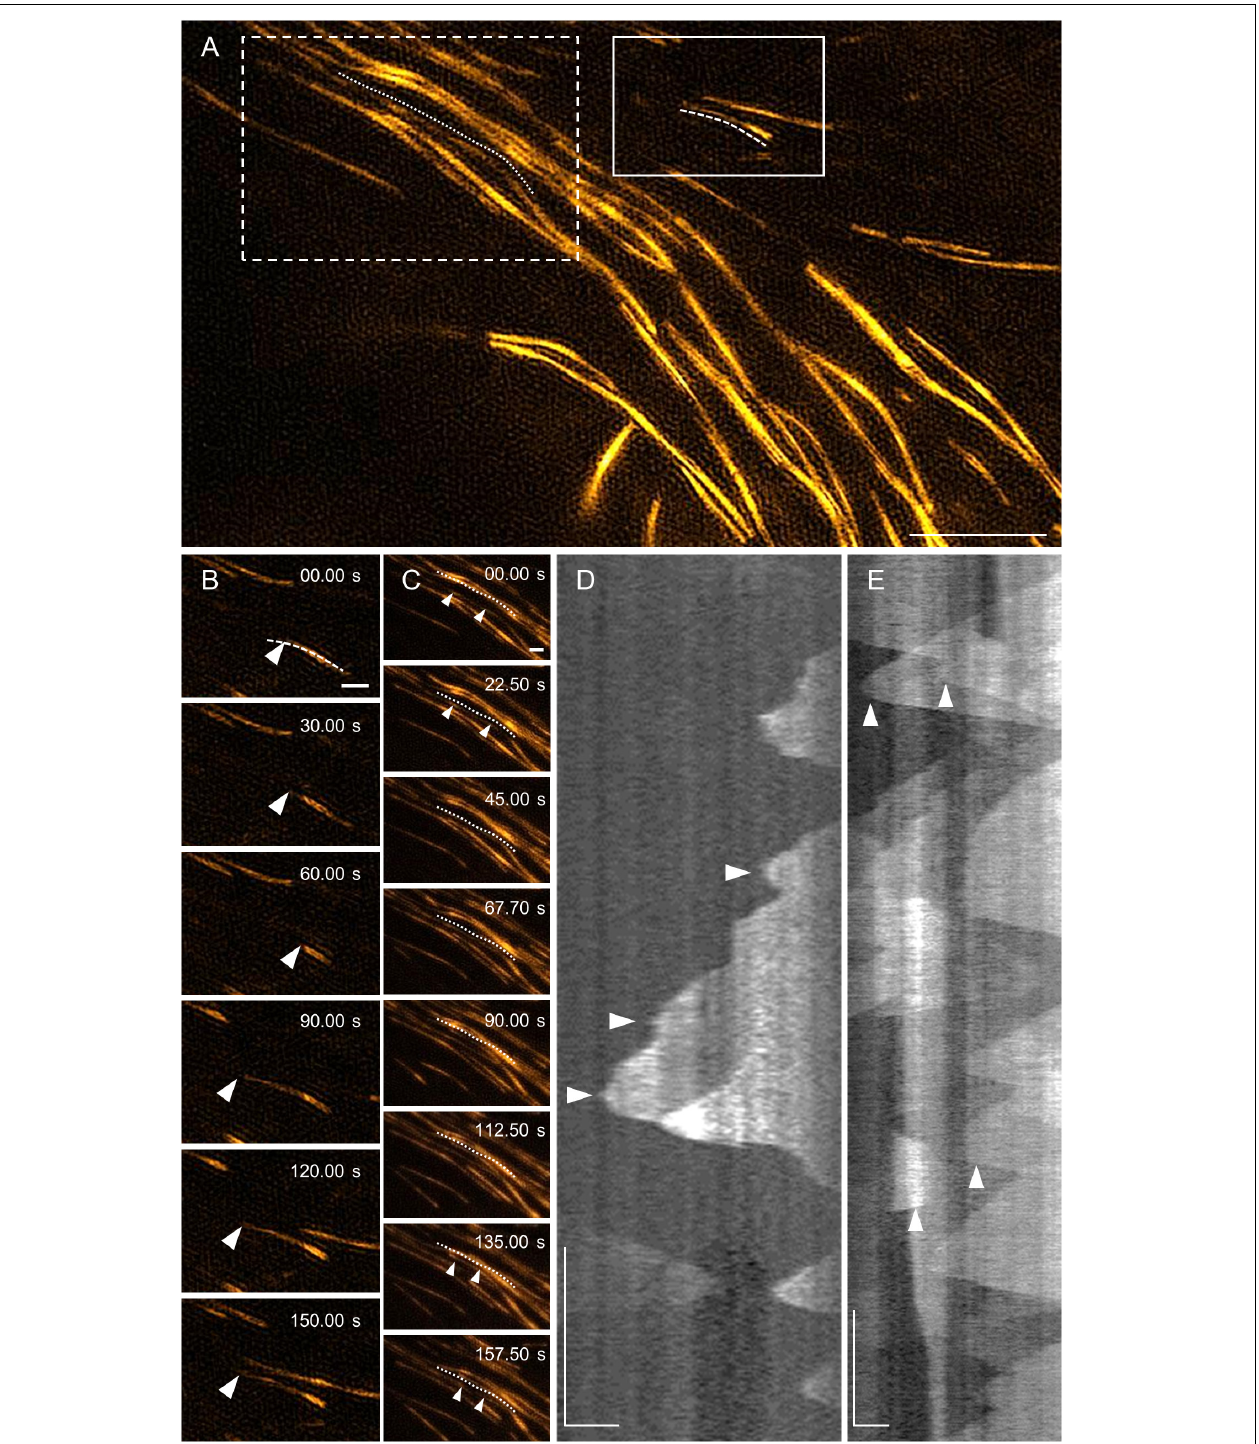
FIGURE 9 | MAP65-2 dynamics visualized by TIRF-SIM (see also Supplementary Video S3 ). (A) An overview of a hypocotyl epidermal cell of stably transformed line expressing eGFP-MAP65-2 observed by TIRF-SIM (objective 100 × /1.49 NA). In full-line box is area, which is magnified and shown in stills in (B) , with dashed line marking microtubule bundle used for generating kymograph in (D) , while in dotted-line box is area depicted in stills in (C) and the dotted line is next to microtubule bundle, from which kymograph of (E) was generated. Stills in (B) show growth of a plus end of an individual microtubule bundle as demonstrated on a kymograph (D) . A complex dynamics within composite microtubule bundle is demonstrated in stills (C) and a corresponding kymograph (E) ; white arrowheads point to microtubule ends. Scale bars = 5 µ m (A) , or 1 µ m (B–E) . Time bars = 1 min (D,E) .